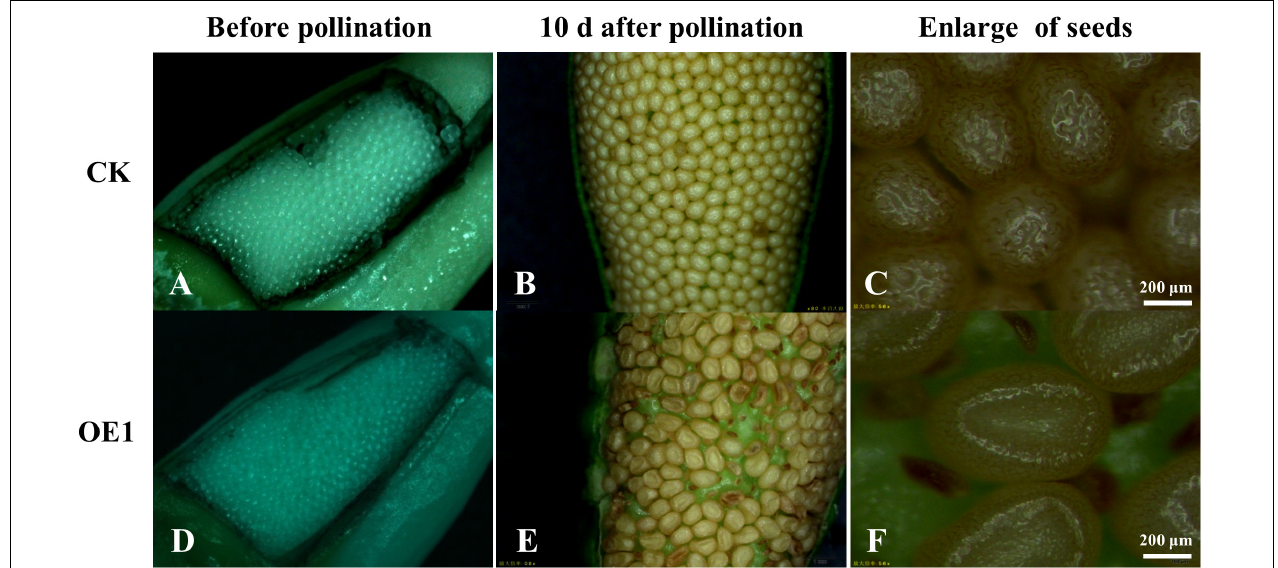
FIGURE 5 | Ectopic expression of PsnCYCD1;1 caused seed fertility in transgenic tobacco. (A,D) Observation of ovules before pollination between CK and transgenic (OE1) line; (B,E) microscopic observation of seeds in the ovary 10 days after pollination with wild-type pollens between CK and transgenic (OE1) line; and (C,F) close-up of the image (B,E) . CK, control plant (A–C) ; OE1, transgenic plant (D–F) .